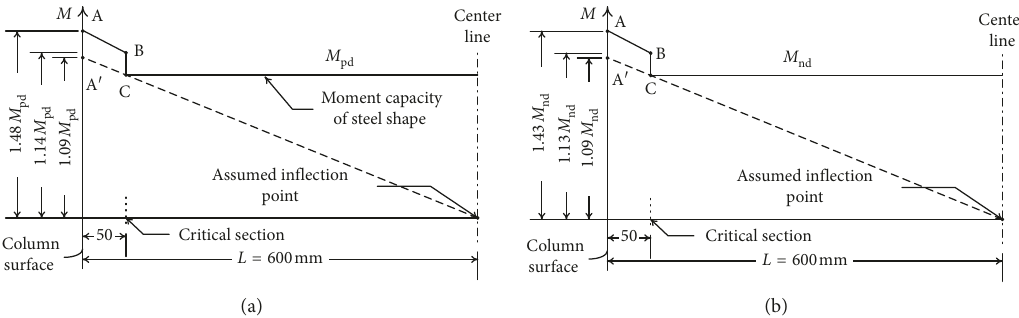
Figure 7: Design moment capacity distribution of the beam with SBC connection. (a) Steel shape; adapted from [15]. (b) Whole section.